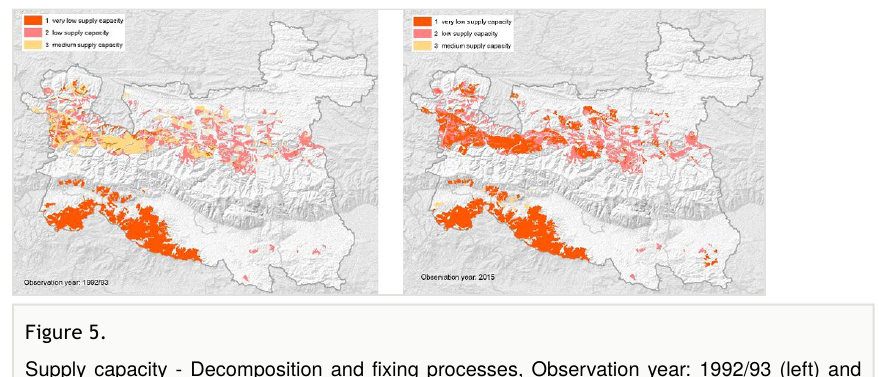
Supply capacity - Decomposition and fi xing processes, Observation year: 1992/93 (left) and 2015